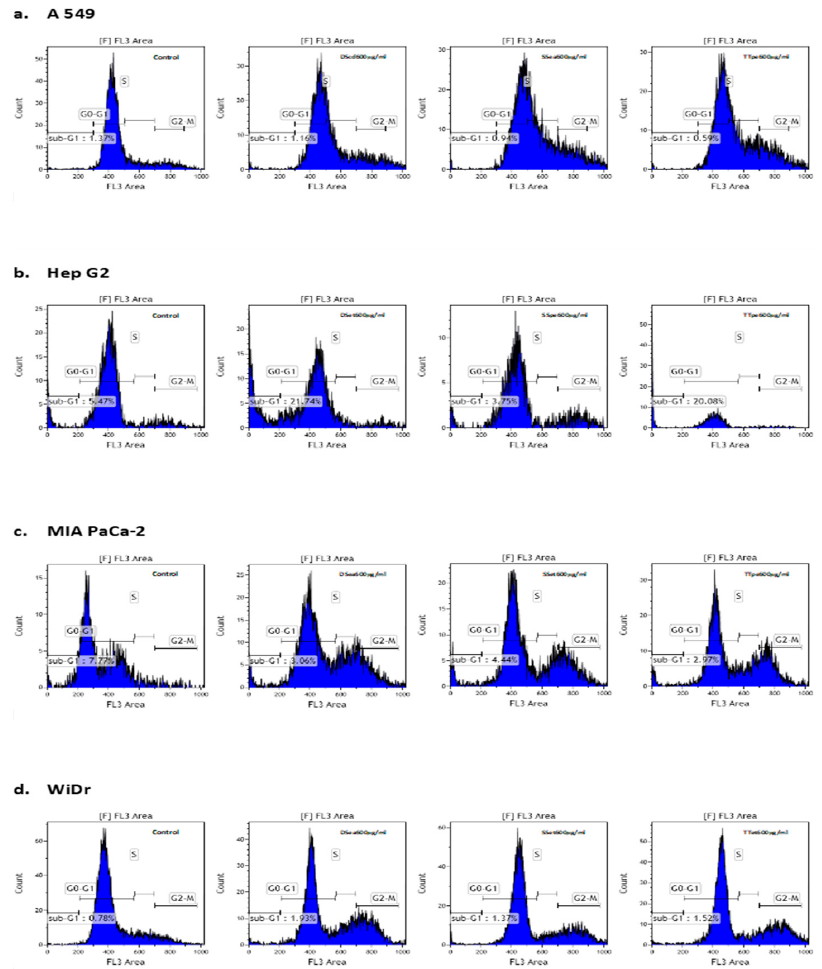
Figure 5. Induction of cell cycle arrest on ( a ) A549 cells (DScd, SSea, and TTpe treatments); ( b ) Hep G2 cells (DSet, SSpe, and TTpe treatments); ( c ) MIA PaCa-2 cells (DSea, SSea, and TTpe treatments), and ( d ) WiDr cells (DSea, SSet, and TTet treatments), respectively by NZ surf clam extracts. Cell lines were treated with 600 µg/mL of various extracts. The percentages of cells in the different phases of cell cycle was determined by PI staining and examined by flow cytometry. Each experiment was carried out twice, in duplicate. Data are represented as mean ± SE.